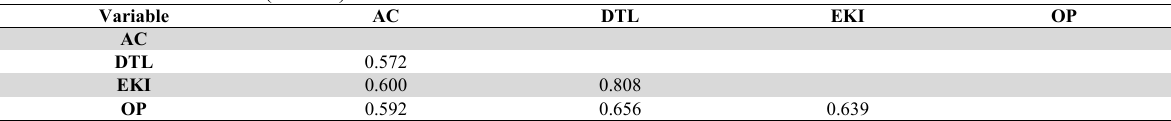
Heterotrait-Monotrait Ratio (HTMT) Variable AC